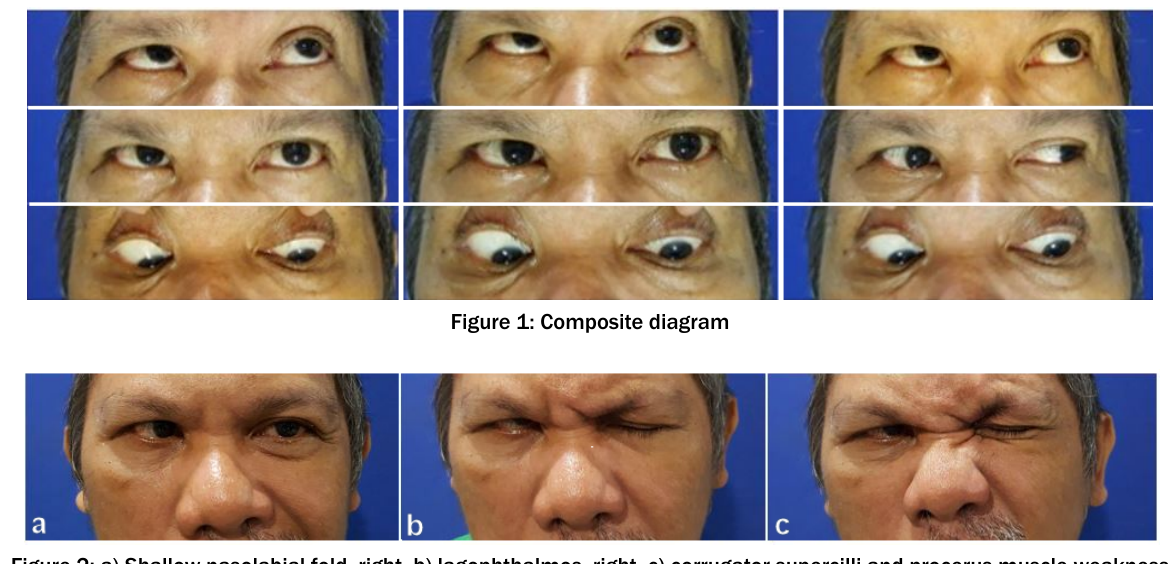
Figure 2: a) Shallow nasolabial fold, right, b) lagophthalmos, right, c) corrugator supercilli and procerus muscle